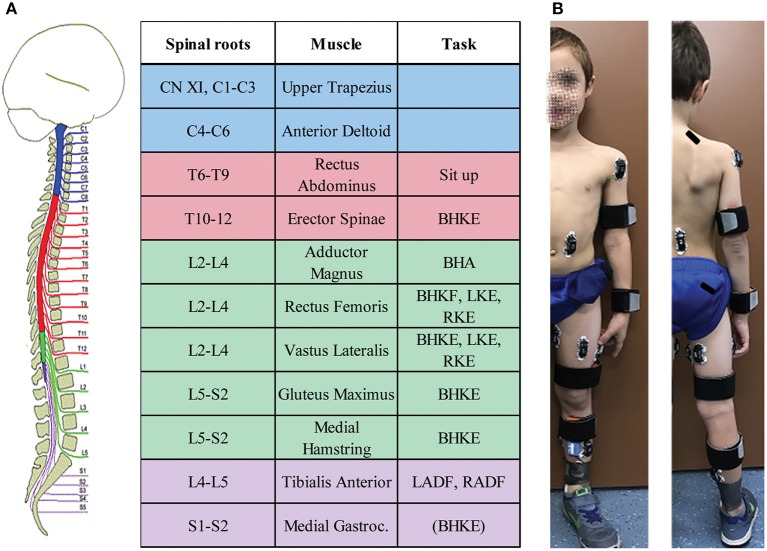
Pediatric functional neurophysiologic assessment summary. (A) Muscles from which EMG is recorded during the assessment, and their respective spinal root innervation. The right-hand column lists the movements used to assess intentional activation for the applicable muscles. (B) Example of electrode placements. Rectus Abdominus electrodes were placed para-umbilically, while erector spinae electrodes were placed with the superior aspect of the electrode at the level of the T10 spinous process. Written informed consent was obtained from the child's parent for the use of this image.